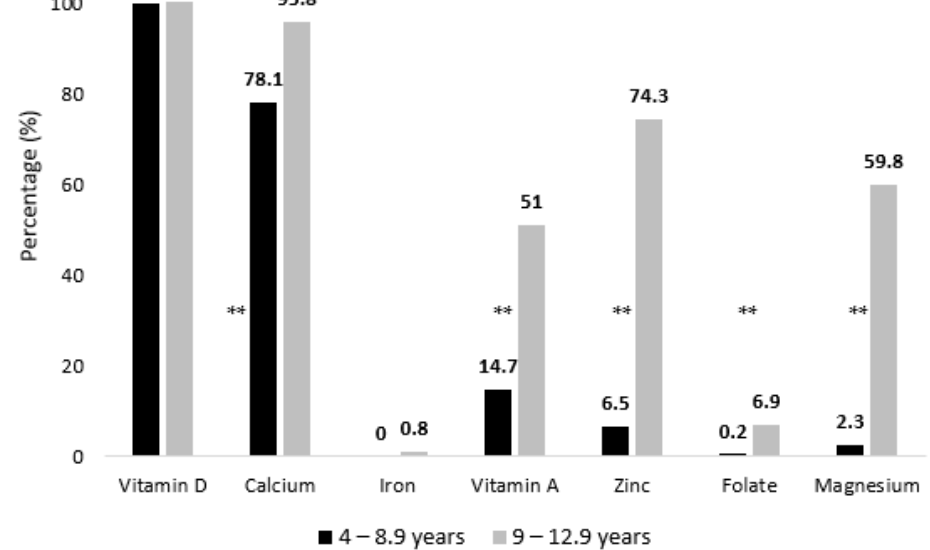
Figure 5. Proportions of UAE Children Aged 4–12.9 Years Consuming Below the EAR of Micronutrients, KNHS 2021. ** Indicates significant difference at p < 0.001.